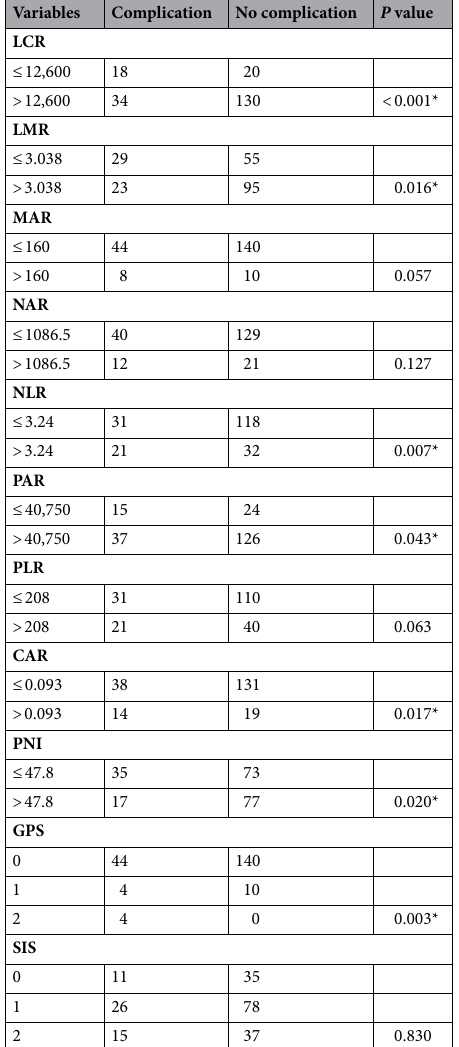
Table 3. Univariate analysis showing the association between 11 combinations of inflammation-related markers and occurrence of postoperative complications. LCR lymphocyte count/C-reactive protein ratio, LMR lymphocyte count/monocyte count ratio, MAR monocyte count/albumin ratio, NAR neutrophil count/albumin ratio, NLR neutrophil count/lymphocyte count ratio, PAR platelet count/albumin ratio, PLR platelet count/ lymphocyte count, CAR C-reactive protein/albumin ratio, PNI prognostic nutritional index, GPS Glasgow prognostic score, SIS systemic inflammation score. * P <